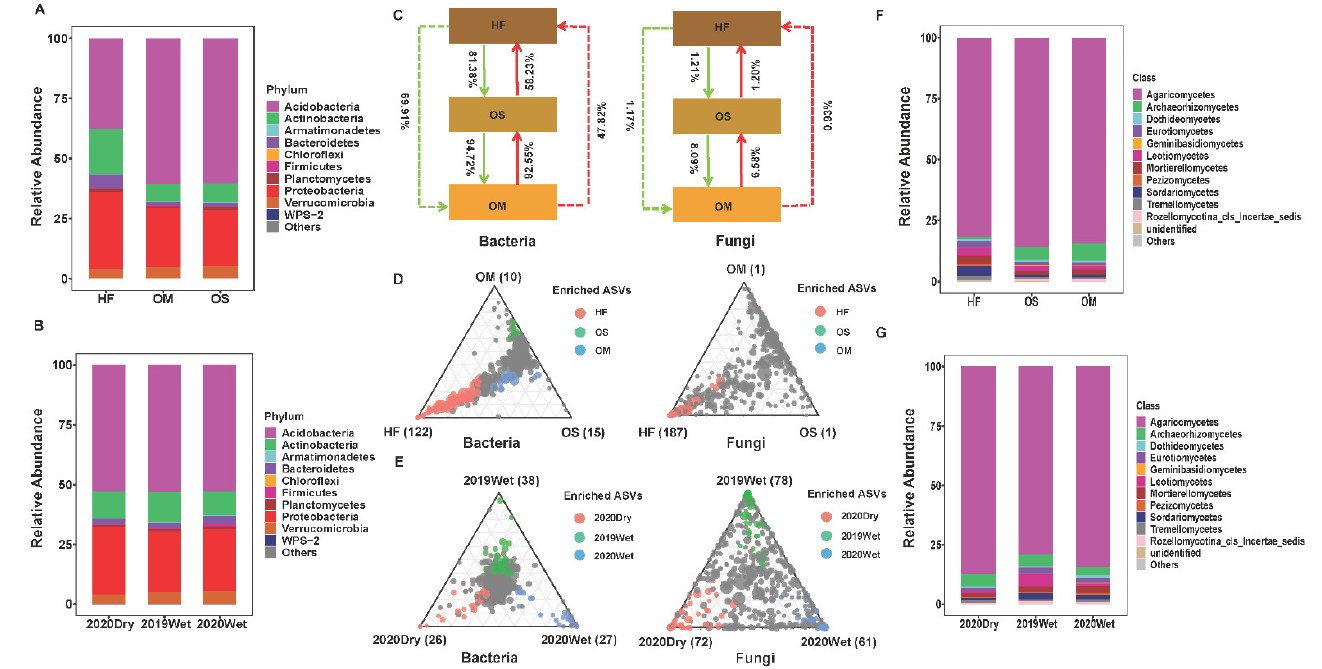
Figure 3. The community composition and selection process of the soil layers. The relative abundance of the most abundant of bacterial phyla ( A ) and fungal ( F ) class among soil layers. The relative abundance of the most abundant of bacterial ( B ) and fungal ( G ) phyla among sampling seasons. ( C ) Source model showing the potential exchange based on all samples. Bacterial and fungal ASVs shared among soil layer ( D ) and sampling season ( E ). Ternary plots depict the relative abundance of all ASVs (>0.5%) for soil layer or sampling season across bacterial and fungal microbiomes. Each point corresponds to an ASV. Its position represents its relative abundance for each soil layer, and its size represents the average across all soil layers. Colored circles represent ASVs enriched in one soil layer compared to the others (red in HF or 2020Dry, green in OS or 2019Wet, and blue in OM or 2020Wet). The phyla with less than 0.05% of the average relative abundance are grouped into